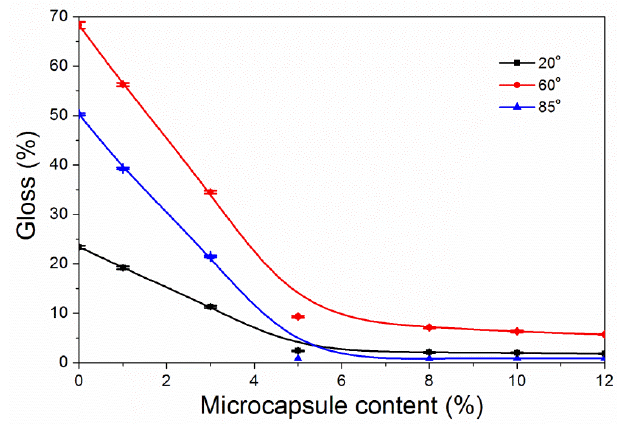
Figure 4. The relationship between the contents of microcapsules and the gloss of coating.